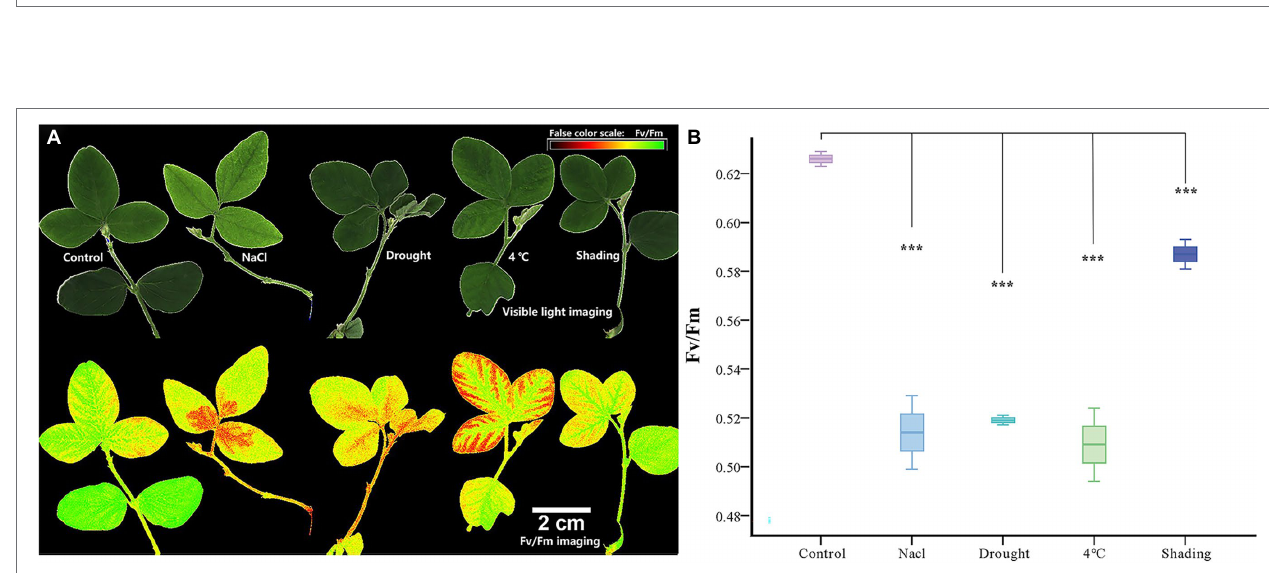
FIGURE 4 | Analysis of the cis-elements of the 2,000 bp promoter sequence upstream of the initial codon of Glycine max P 2 -type ATPases genes from the evolutionary level. Different color graphics represent different cis-elements and positions on the